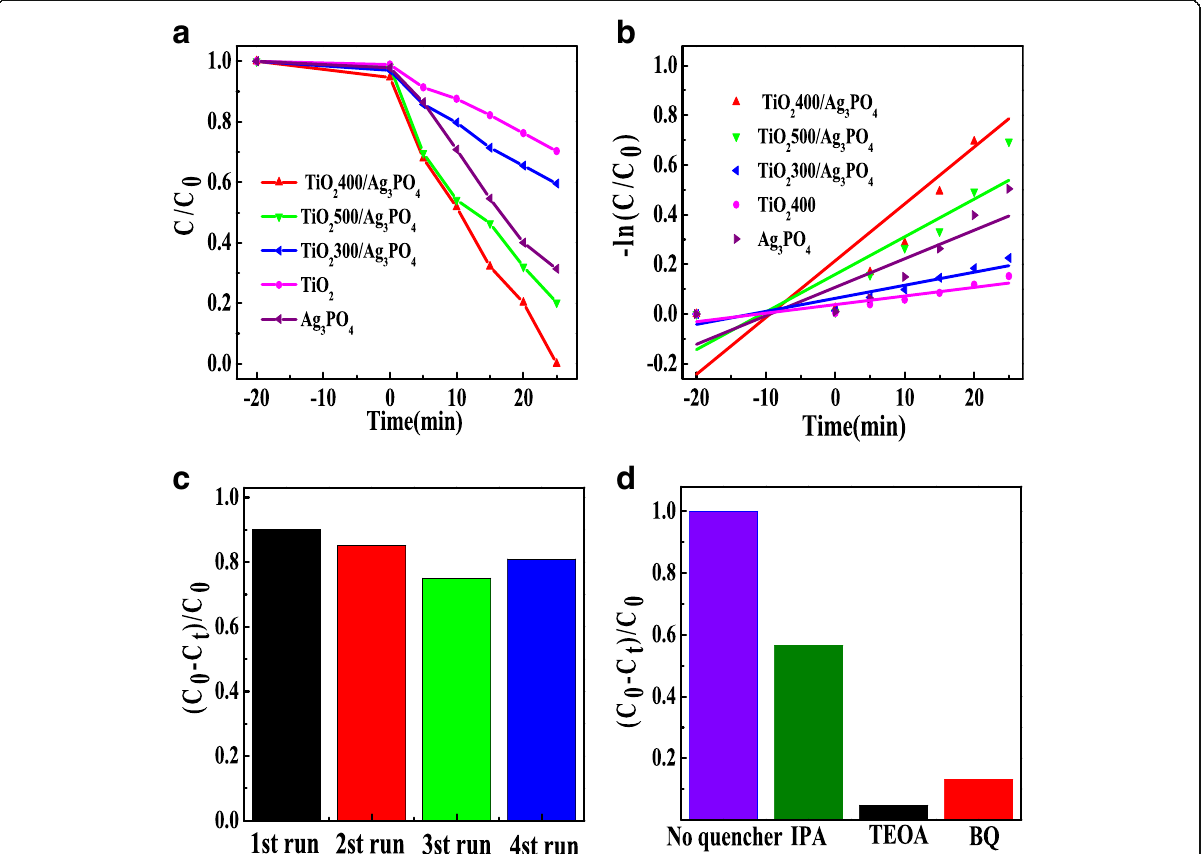
Fig. 5 a Effects of different catalysts on photocatalytic degradation of RhB under visible light. b First order kinetic fitting plots of photocatalytic degradation of RhB with different catalysts. c Cycling runs of TiO 2 400/Ag 3 PO 4 . d Trapping experiments of active species